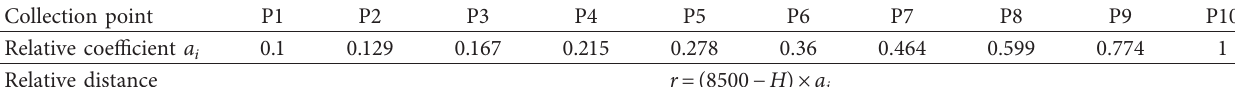
Figure 4: Seismic energy (a) and signal-to-noise ratios (b) under different charge Table 5: Distribution of data collection points.